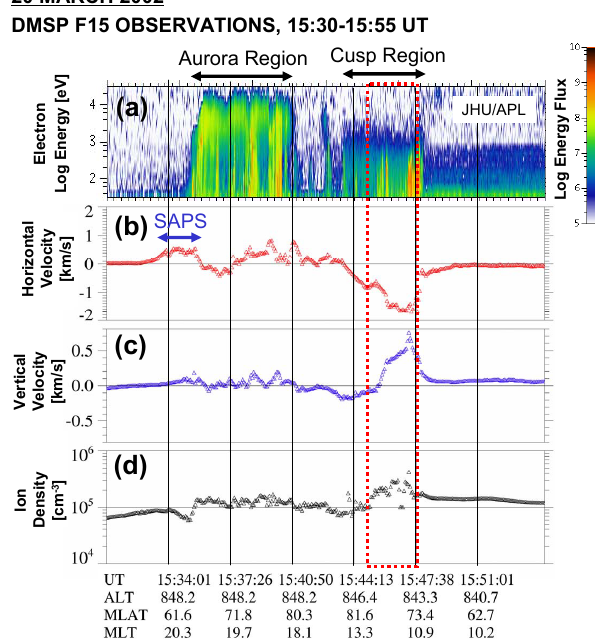
Fig. 4. (a) Low energy electron flux, (b) the horizontal component (positive sunward) and (c) vertical component (positive upward) of ion drift velocity, and (d) ion number density observed by DMSP F15 on 20 March 2002. A region of strong anti-sunward plasma convection is denoted by the dashed